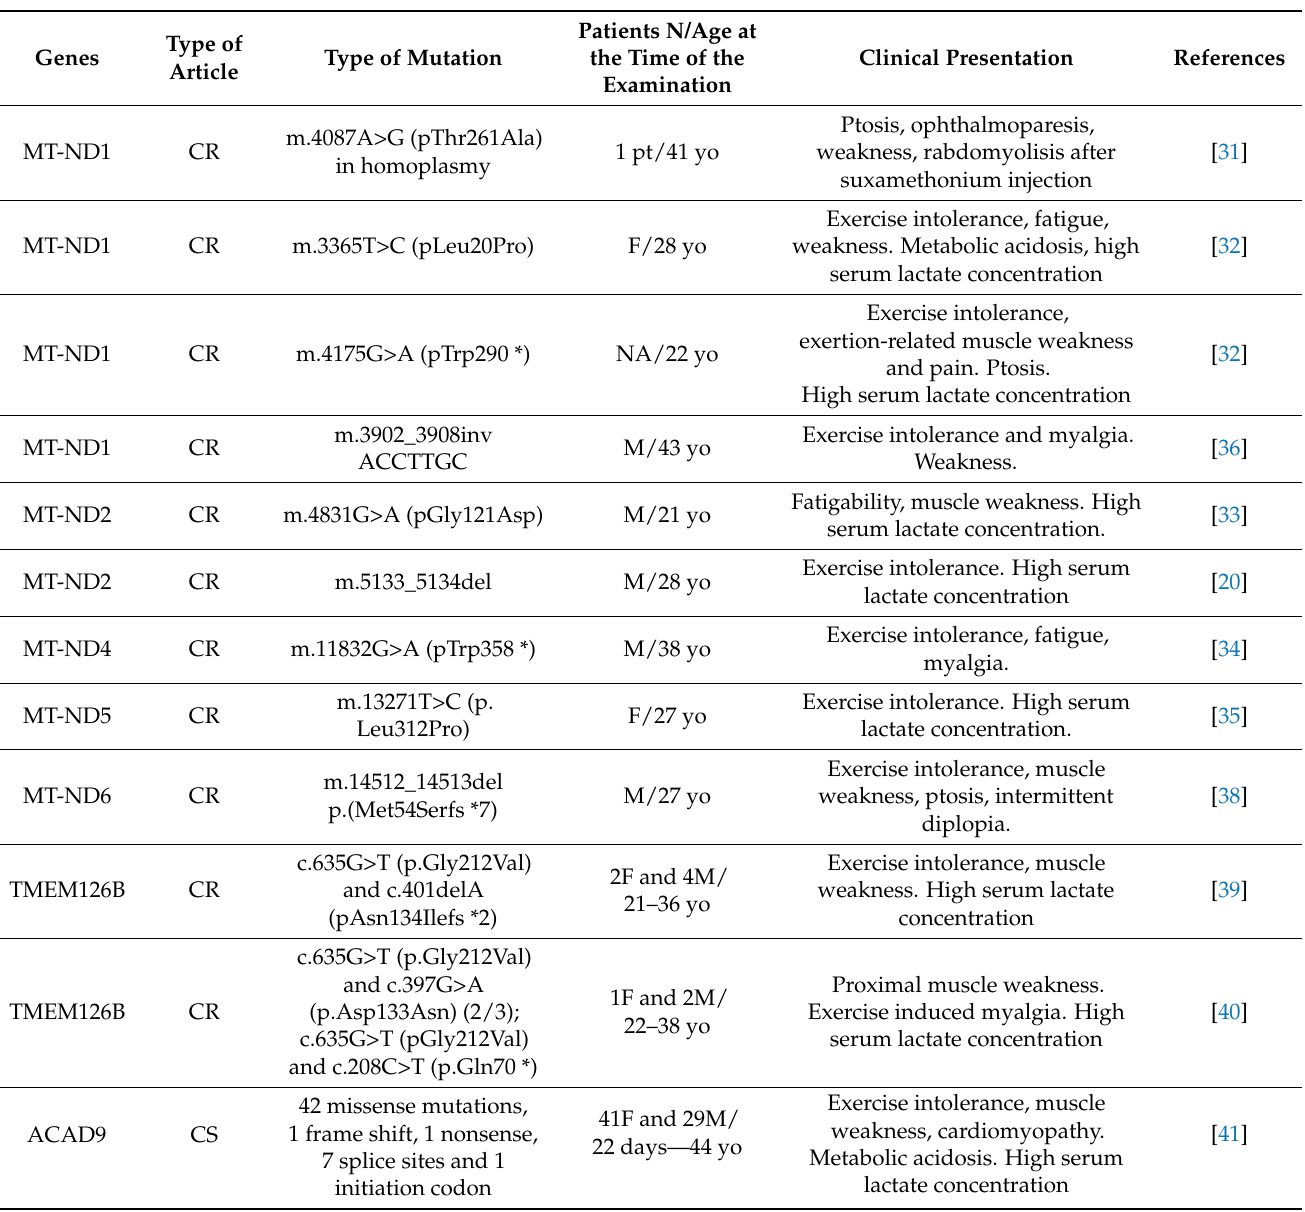
Table 3. Examples of genetic alterations of isolated MRC Complex I to V deficiency with a predomi- nant muscular involvement phenotype (or isolated mitochondrial